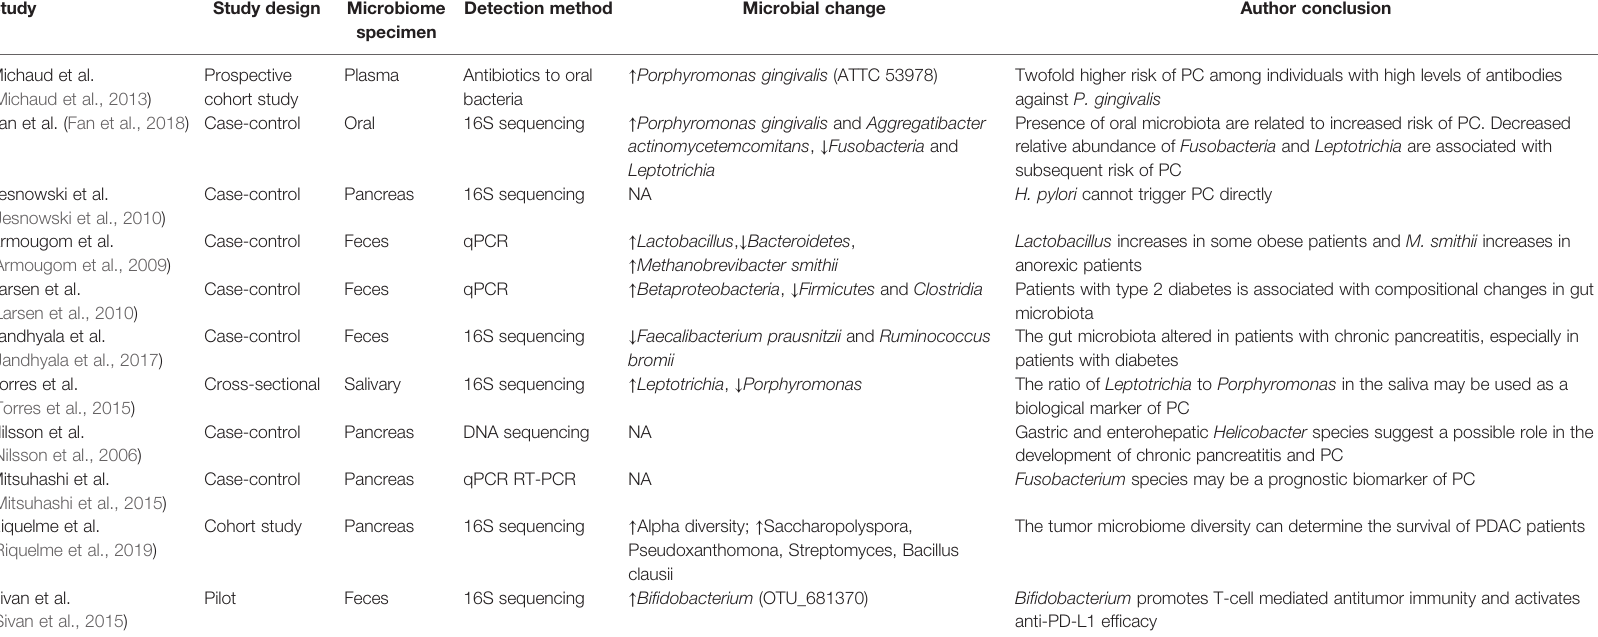
TABLE 1 | Overview of the major gut microbiota studies involving pancreatic